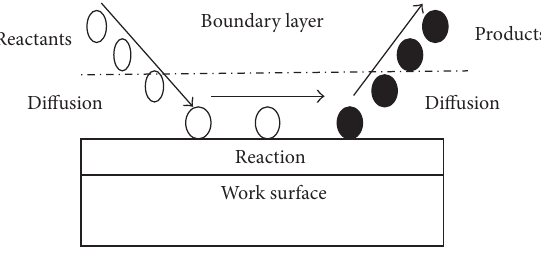
Figure 3: Photochemical machining mechanism. Table 1: Input